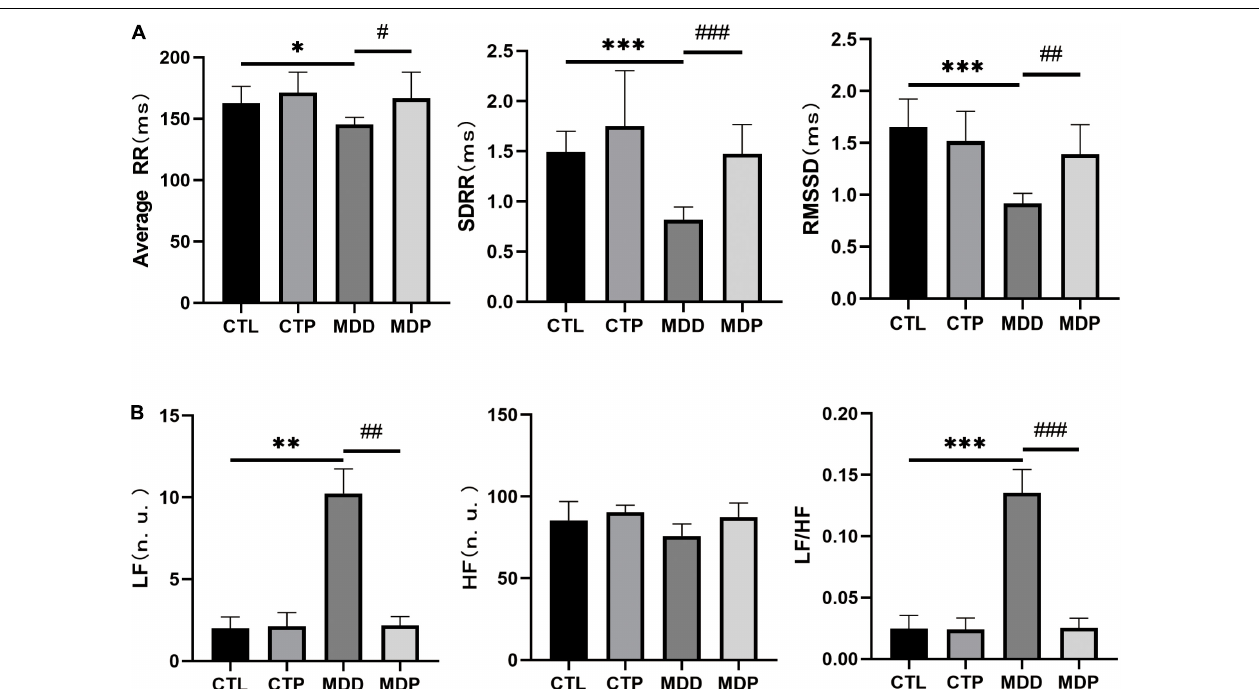
FIGURE 2 | Statistical analyses of HRV. (A) Average RR, SDRR, and RMSSD. (B) LF, HF, and LF/HF. n = 8 per group. * p < 0.05, ** p < 0.01, *** p < 0.001 vs. CTL; # p < 0.05, ## p < 0.01, ### p < 0.001 vs. MDD.